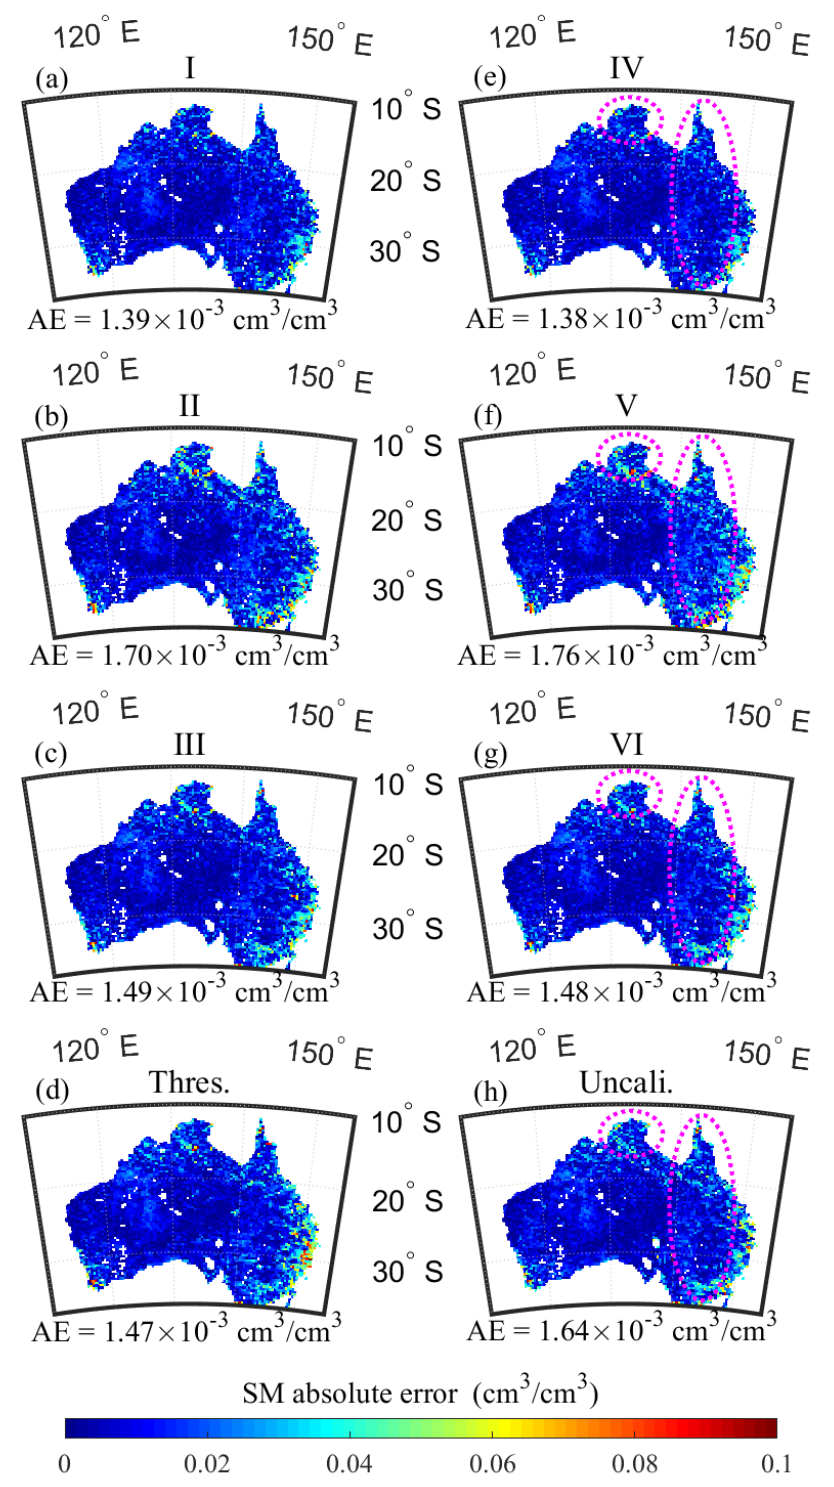
Figure 9. Absolute errors of retrieved SM for November 2020 using: ( a ) Scheme I, ( b ) Scheme II, ( c ) Scheme III, ( d ) Thres., ( e ) Scheme IV, ( f ) Scheme V, ( g ) Scheme VI, and ( h ) Uncali. In general, Schemes I and IV exhibit less errors (see the indication by